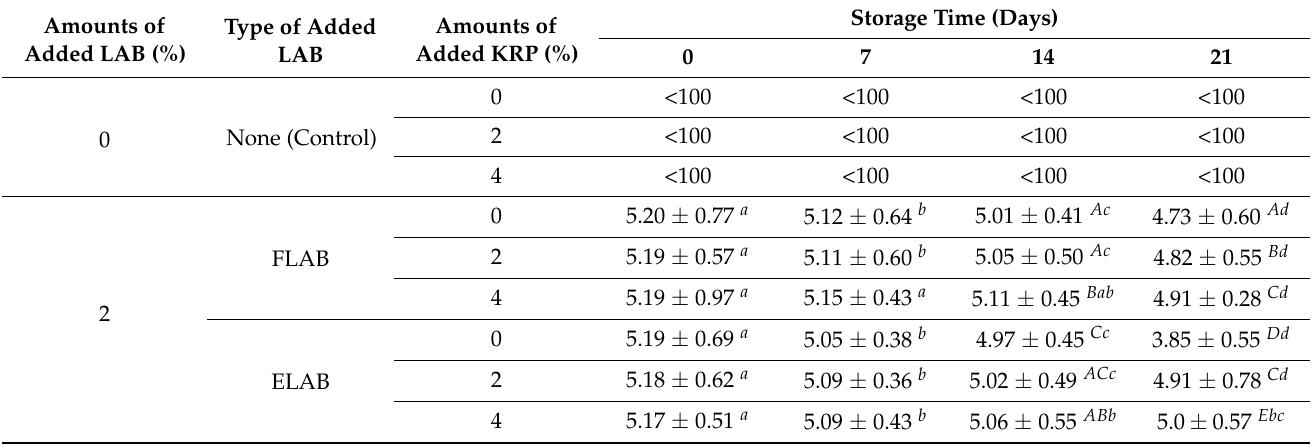
Table 2. Impact of various concentrations of Konjac root powder (KRP) and storage time on the counts (log CFU/mL) of lactic acid bacteria (LAB) in chocolate milk inoculated with free LAB (FLAB) or encapsulated (ELAB). Data are presented as mean ± SD ( n = 9). Means followed with a different